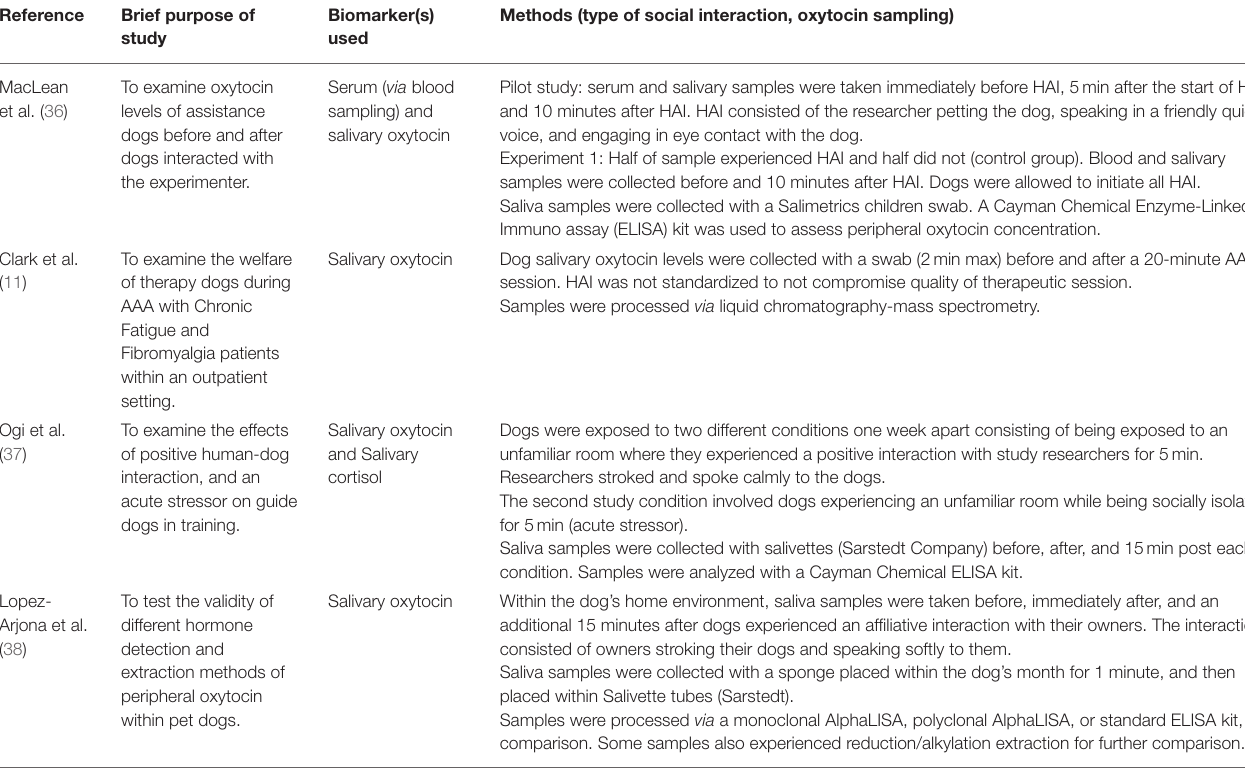
TABLE 2 | Examples of studies examining salivary peripheral oxytocin concentration in pet or working dogs during human-animal interaction.